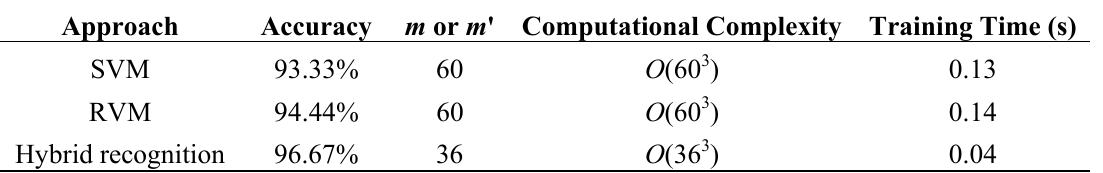
Table 7. In the second part of experiment 2, the recognition accuracy of Iris data set and computational complexity are compared among three